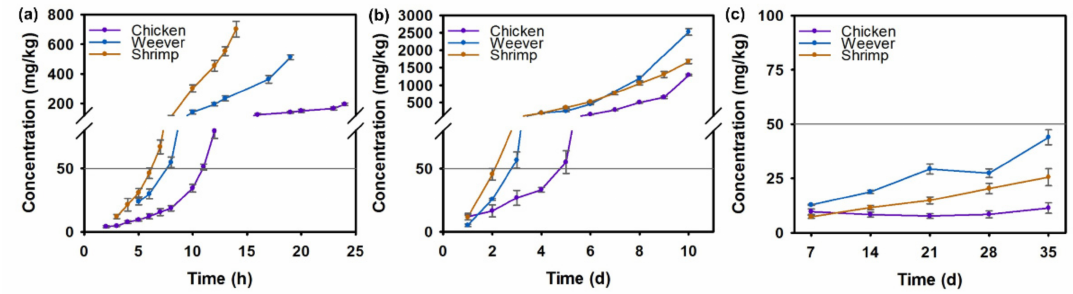
Figure 4. Real-time BAI monitoring of chicken, weeverfish, and shrimp at different storage tempera- tures using the HPLC method: ( a ) 25 ◦ C, ( b ) 4 ◦ C, and ( c ) − 20 ◦ C. The red dashed line shows the BAI concentration of 50 mg/kg, which indicates spoilage.